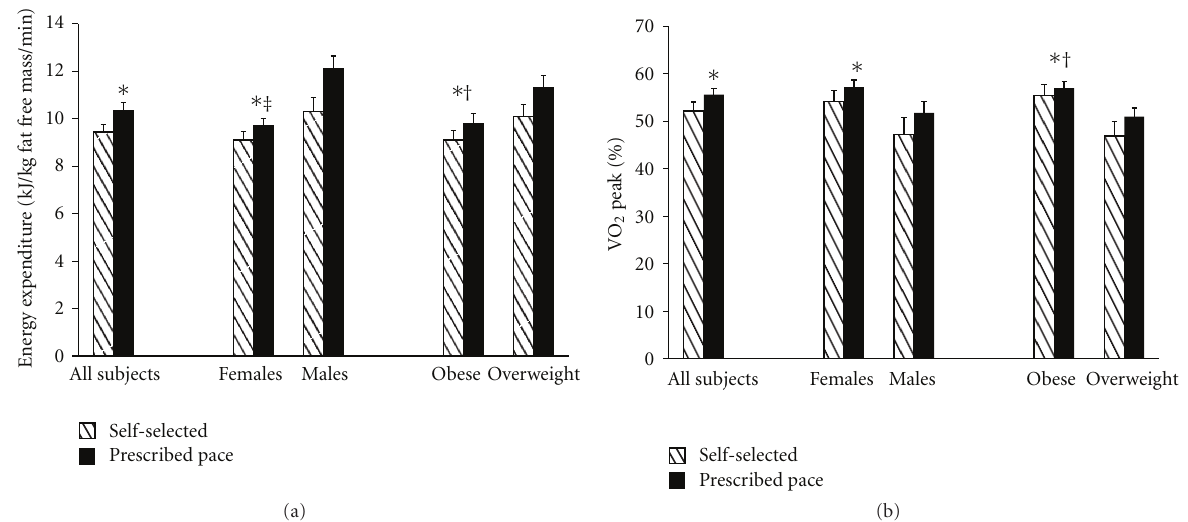
Figure 1: The rate of energy expenditure (a) and percent peak oxygen consumption (VO 2 peak) (b) for the self-selected walking pace and the prescribed walking pace for 33 overweight subjects during 30 minutes of exercise. ∗ P < 0 . 05 between the self-selected and prescribed pace; † P < 0 . 05 between obese and overweight subjects; ‡ P < 0 . 01 between men and women.